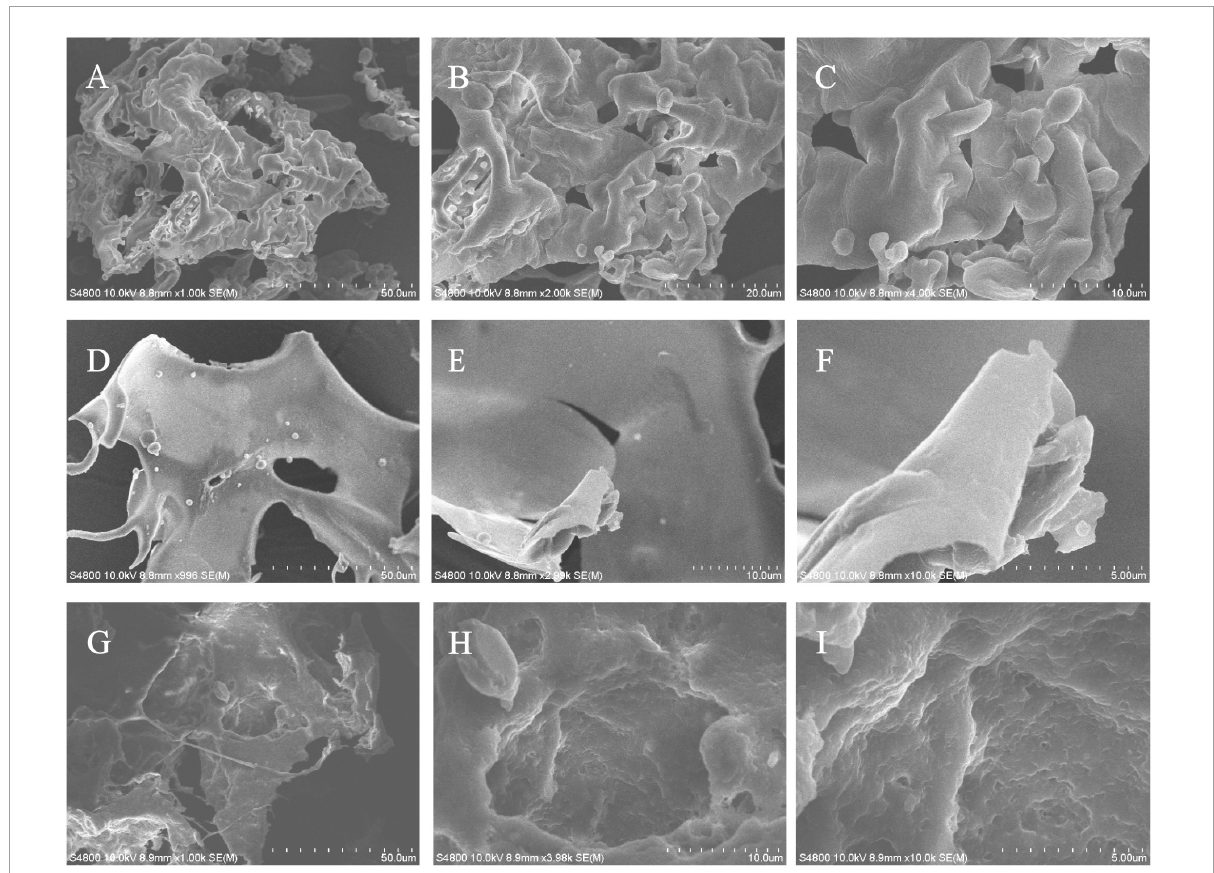
FIGURE6 The microstructure and surface morphology of purified EPS fractions observed by SEM analysis. (A) SEM image of EPS1 in the scale bar of 50 µ m. (B) SEM image of EPS1 in the scale bar of 10 µ m. (C) SEM image of EPS1 in the scale bar of 5 µ m. (D) SEM image of EPS2 in the scale bar of 50 µ m. (E) SEM image of EPS2 in the scale bar of 10 µ m. (F) SEM image of EPS2 in the scale bar of 5 µ m. (G) SEM image of EPS3 in the scale bar of 50 µ m. (H) SEM image of EPS3 in the scale bar of 10 µ m. (I) SEM image of EPS3 in the scale bar of 5 µ